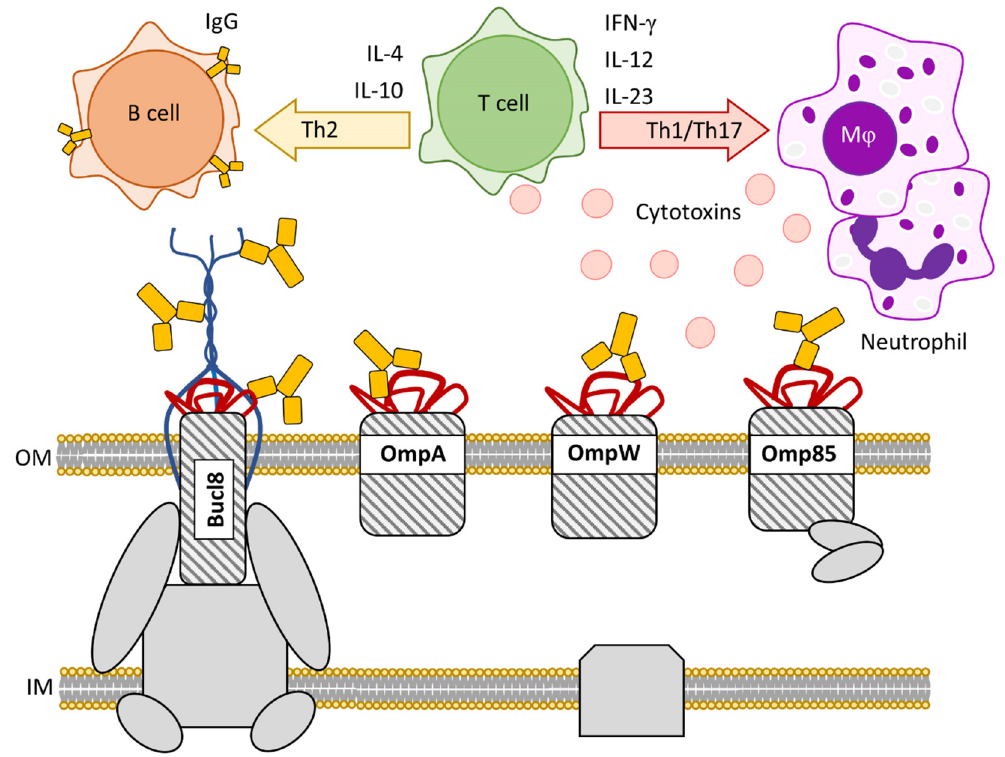
Figure 4. Utilizing Burkholderia antigens derived from outer membrane proteins for vaccine targets. OmpA, OmpW, Omp85, and Bucl8 are the outer membrane components of bacterial transport systems in Burkholderia spp. that have been previously identified as vaccine targets. OMPs are exploitable antigens due to surface-exposed loops and extended structures, as found in Bucl8. OMP-derived products stimulate long-lasting Th1/Th17/Th2 immune responses that augment opsonophagocytic and cytotoxic activities against invading Burkholderia